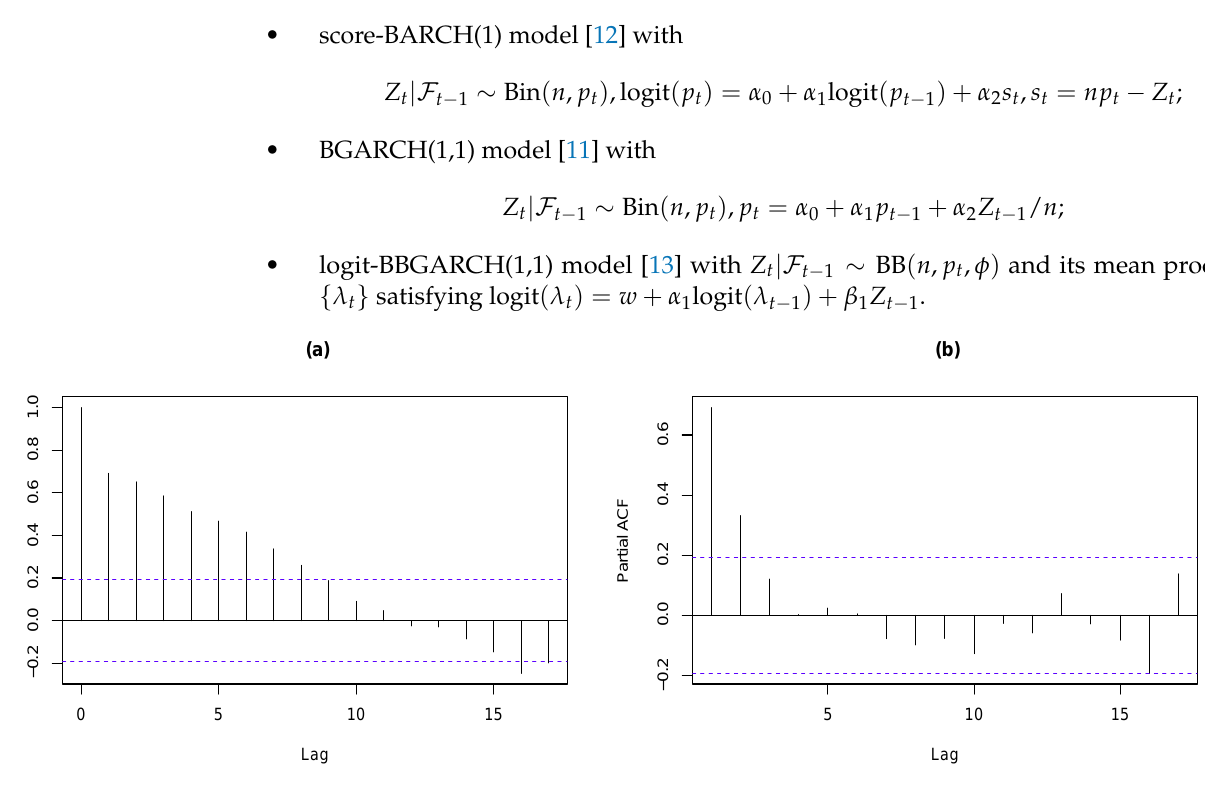
Figure 9. Measles infection’s counts: ( a ) ACF, ( b )